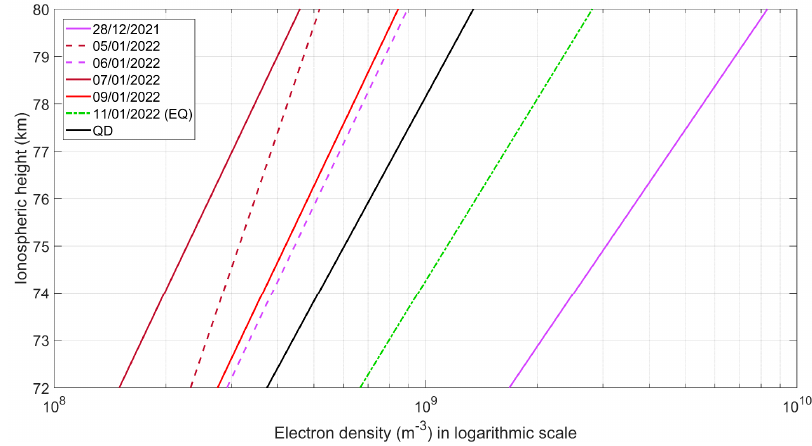
Figure 16. Same as Figure 15 for SST of ISR–UWA path.